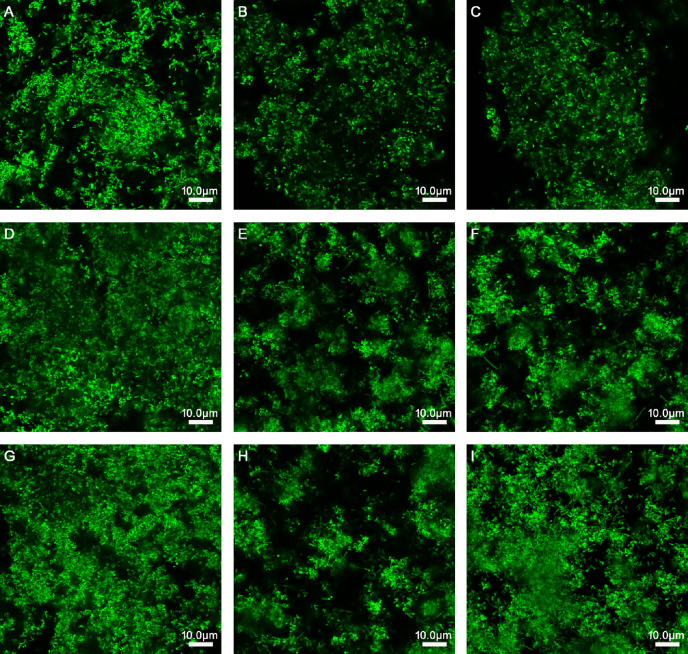
Effects of Lactobacillus species on different stages of biofilm formation of Gardnerella species. (A) 150 μl of Gardnerella species suspension and 150 μl of supplemented brain–heart infusion (sBHI) were mixed and cultured for 24 h. (B) 150 μl of Gardnerella species suspension and 150 μl of L. rhamnosus suspension were mixed and cultured for 24 h. (C) 150 μl of Gardnerella species suspension and 150 μl of L. casei suspension were mixed and cultured for 24 h. (D) After culturing 150 μl of Gardnerella species suspension alone for 24 h, 150 μl of sBHI was added and the mixture was cultured for 24 h. (E) After culturing 150 μl of Gardnerella species suspension alone for 24 h, 150 μl of L. rhamnosus suspension was added, followed by coculturing for 24 h. (F) After culturing 150 μl of Gardnerella species suspension alone for 24 h, 150 μl of L. casei suspension was added and the cells were cultured for another 24 h. (G) After culturing 150 μl of Gardnerella species suspension alone for 48 h, 150 μl of sBHI was added and the mixture was cultured for 24 h. (H) After culturing 150 μl of Gardnerella species suspension alone for 48 h, 150 μl of L. rhamnosus suspension was added and the mixture was cultured for another 24 h. (I) After culturing 150 μl of Gardnerella species suspension alone for 48 h, 150 μl of L. casei suspension was added and the mixture was cultured for 24 h. The images were captured at a magnification of 63× combined with 0.75 zoom.